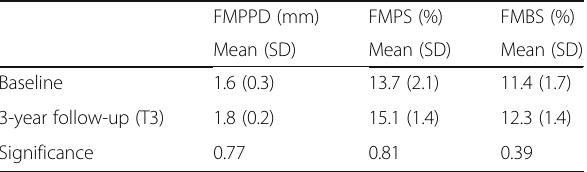
Table 4 Patients ’ full-mouth periodontal probing depth (FMPPD), full-mouth plaque score (FMPS), and full-mouth bleeding score (FMBS) recorded during the follow-up period